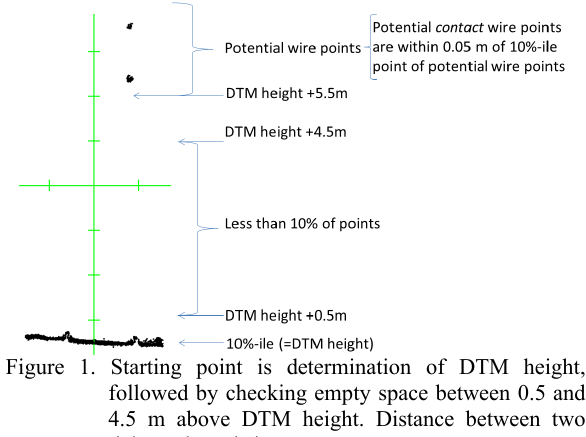
Figure 1. Starting point is determination of DTM height, followed by checking empty space between 0.5 and 4.5 m above DTM height. Distance between two ticks at the axis is one meter.